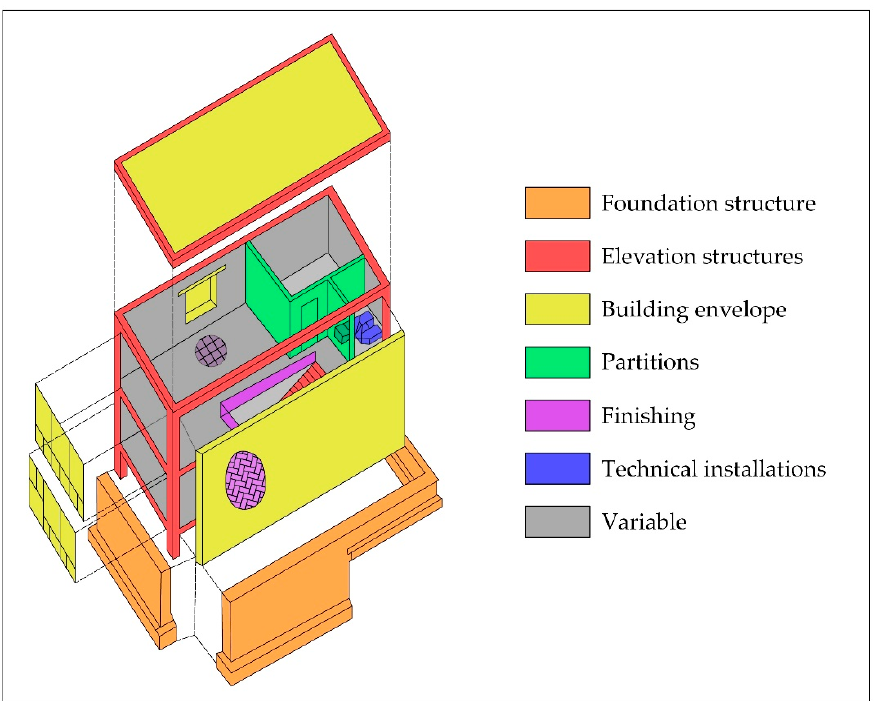
Figure 8. Building decomposition (drawing by G.B.).